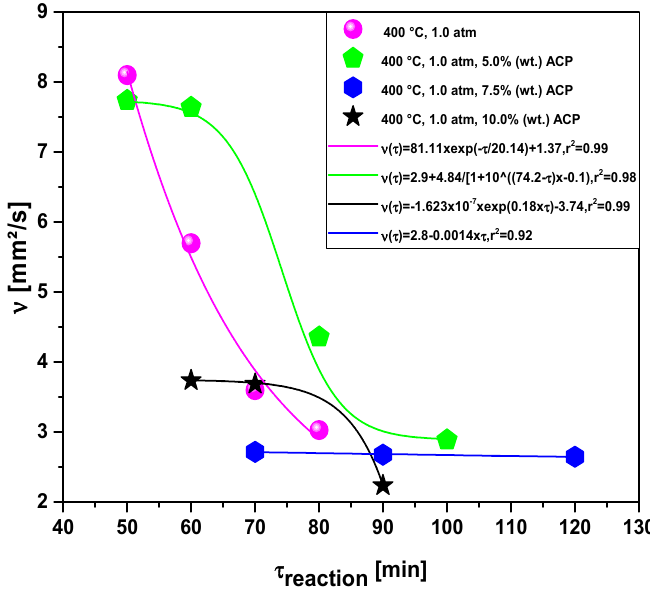
Figure 15. Effect of reaction time on the kinematic viscosity of bio-oil by the upgrading of residual fat pyrolysis vapors at 400 °C, 1.0 atmosphere, 0.0%, 5.0%, 7.5%, and 10.0% (wt.) of activated carbon pellets impregnated with 10.0 M NaOH, using a catalyst fixed-bed reactor, in a semi-pilot scale two-stage reactor of 2.0 L.